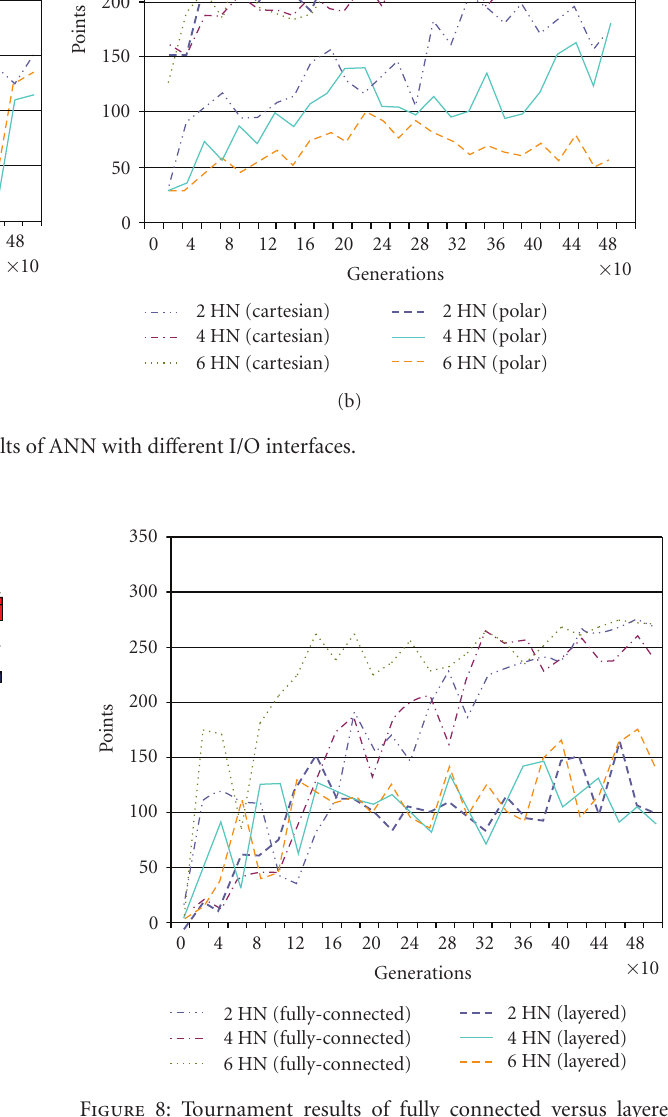
Figure 8: Tournament results of fully connected versus layered ANN with cartesian